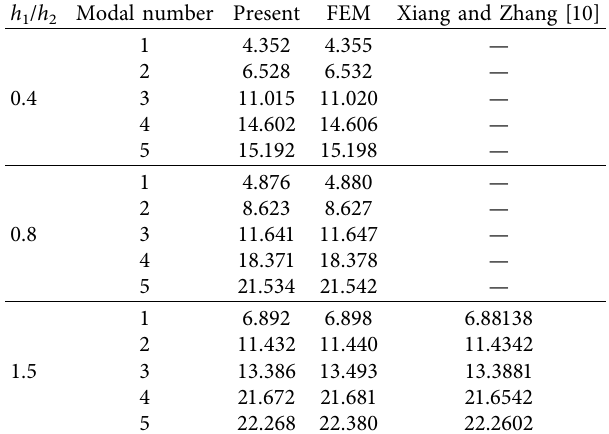
������ 􏽰 Table 3: Dimensionless frequency parameters Ω � ω b 2 ρ h / D 2 2 for stepped circular Mindlin plate with simply supported boundary condition ( υ � 0 . 3 )